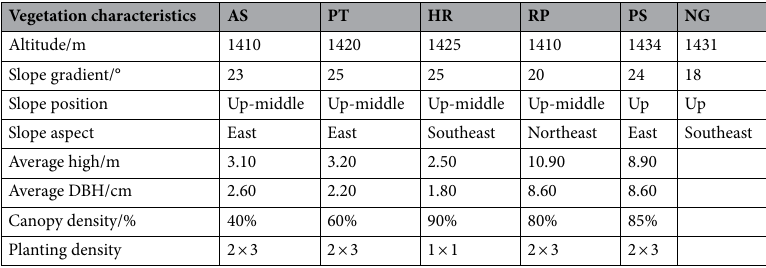
Table 1. Basic situation of the different types of vegetation.